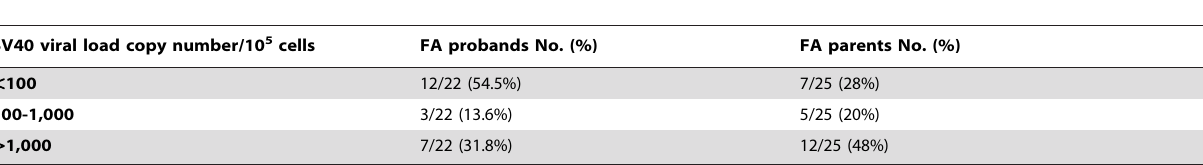
Table 3. Distribution of SV40 LT viral load in FA probands and